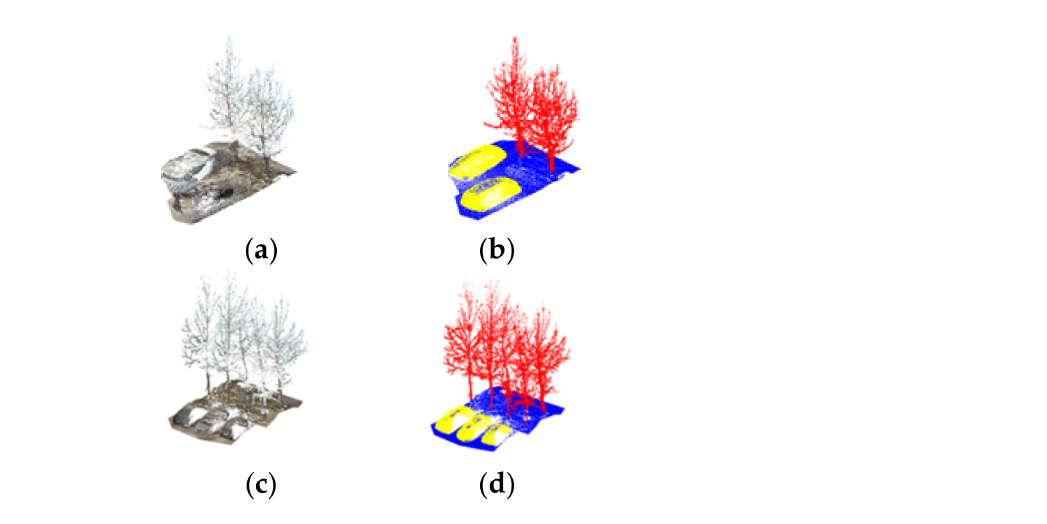
Figure 4. Scene 1 point cloud data. ( a ) Original point cloud of the training set; ( b ) ground truth for the training set; ( c ) original point cloud of the test set; and ( d ) ground truth for the test set. Red, yellow, and blue points represent trees, cars, and floors, respectively.